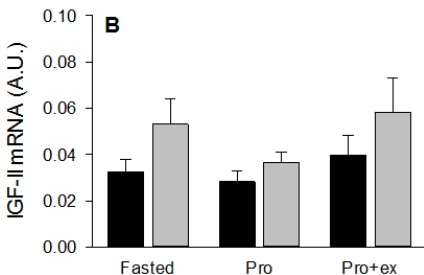
Figure 5. Effect of aging on IGF-I and IGF-II mRNA expression after resistance exercise and protein intake. ( A ) IGF-I and ( B ) IGF-II mRNA levels in Fasted, Pro, and Pro+ex conditions in young and older subjects. Values are means ± SEM. * p < 0.05 vs. Young same condition.